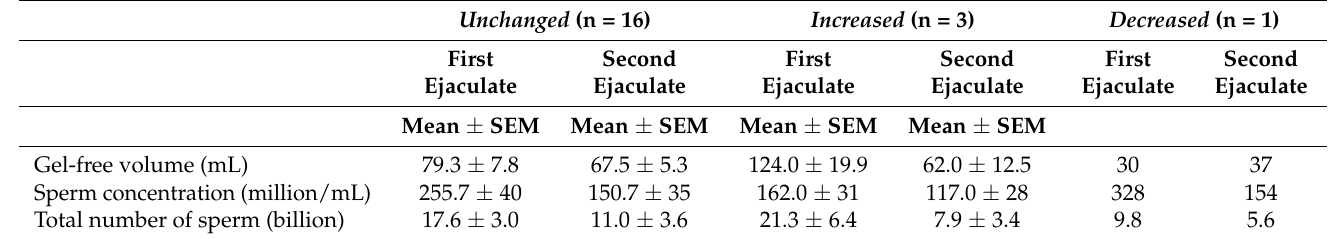
Table 3. Gel-free semen volume, sperm concentration, and total number of sperm of raw semen from the first and second ejaculates of breeding inactive stallions (n = 20). Based on the motility parameters between the first and second ejaculates, sixteen stallions were classified as unchanged (i.e., ≤ 10% change), three stallions as increased (i.e., improvement > 10%) group, and one stallion as decreased (i.e., reduction > 10%). Unchanged (n = 16) Increased (n =